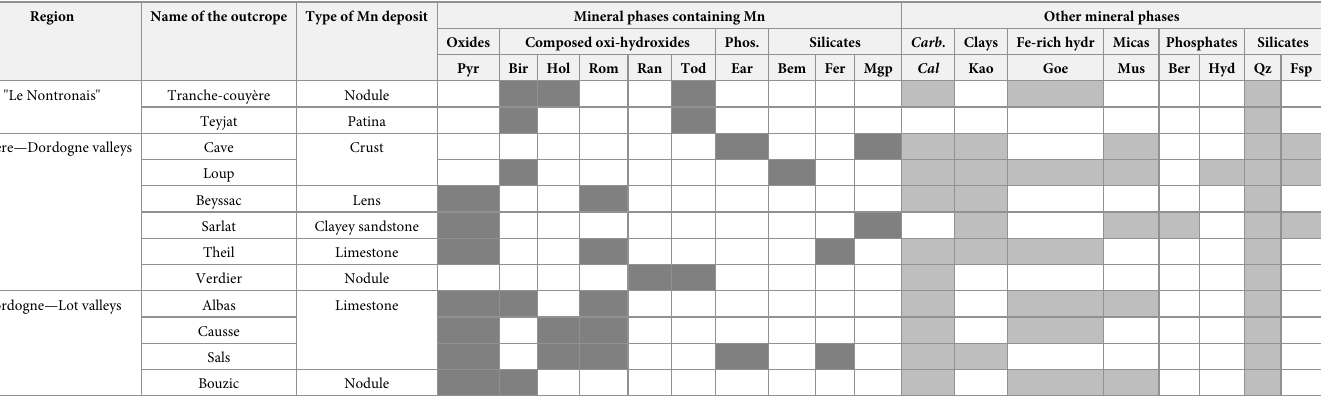
Table 5. Results of XRD analyses of geological samples. Region